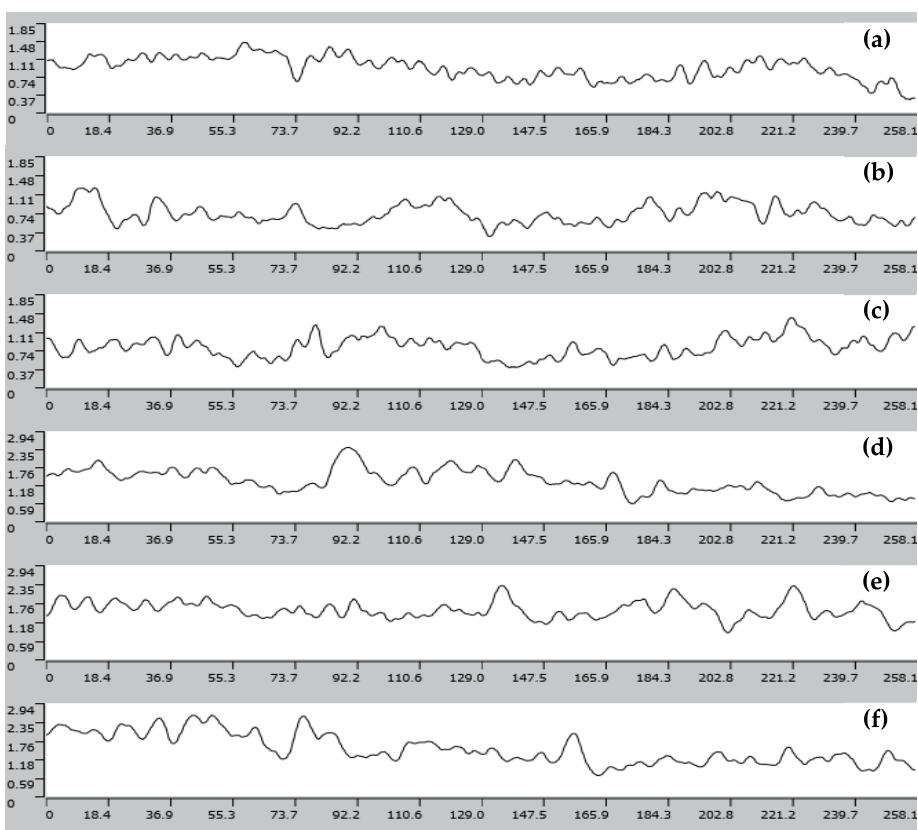
Figure 7. The surface roughness analysis of sample obtained by one-step method A ( a ) area 1, ( b ) area 2, ( c ) area 3 and B ( d ) area 1, ( e ) area 2 and ( f ) area 3.